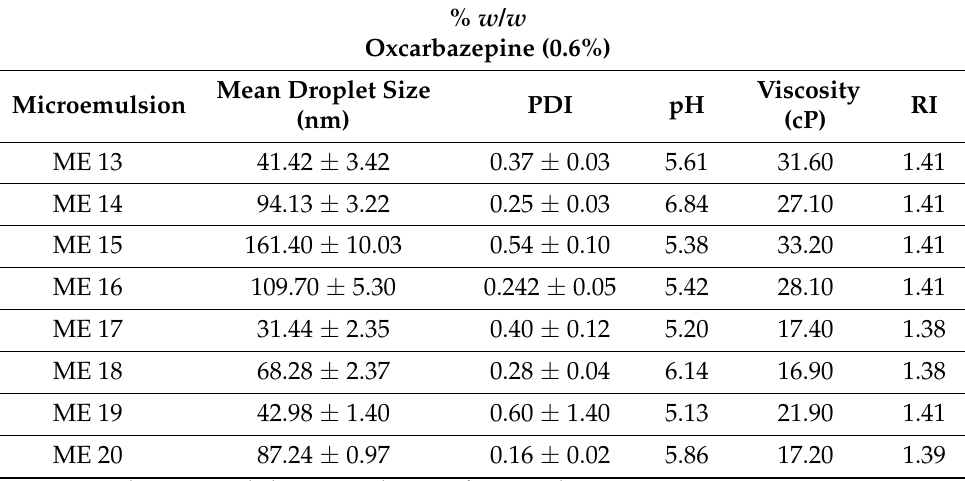
Table 6. Droplet size, pH, RI, PDI and viscosity of oxcarbazepine microemulsions.